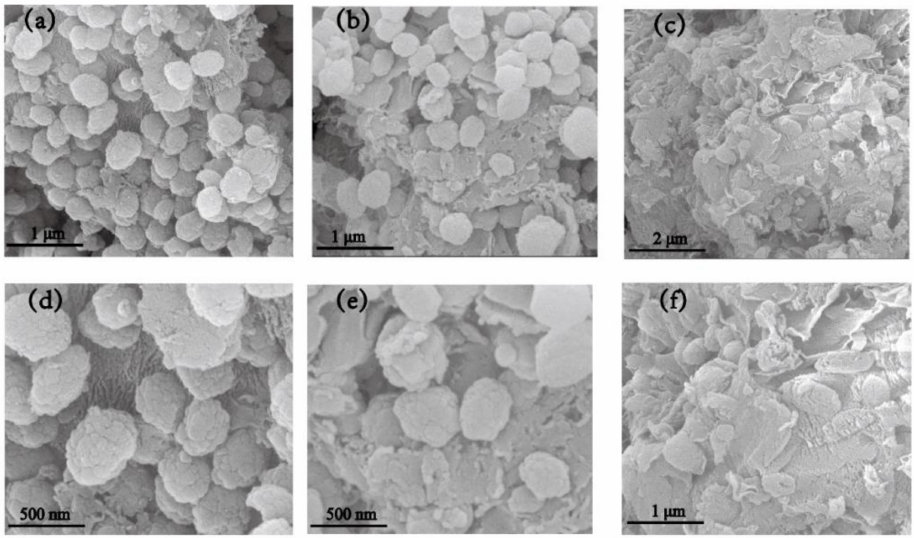
Figure 3. SEM images of TC-A ( a , d ), TC-B ( b , e ) and TC-C ( c , f ).